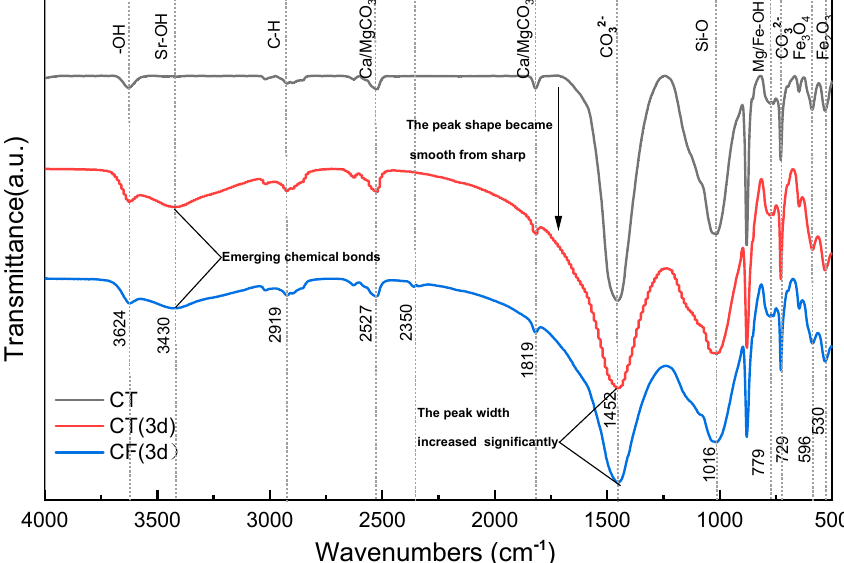
Figure 6. FTIR spectrum of claystone before and after the sorption of Sr. The FTIR spectra of claystone before and after Sr sorption show that the peak shape of the FTIR curve of claystone changed greatly after Sr sorption. In the absence of colloids, the peak intensity of the sorption peak at 3624 cm − 1 increased, but the displacement was not obvious. A new band appeared at 3430 cm − 1 , which had a weak peak intensity but a large peak width, indicating that the Sr in the solution formed a conjoining body with the free -OH in the claystone, and the degree of conjoining was high. In the process of Sr sorption by claystone, the chemical bond polarization was greatly increased and the vibration frequency was reduced due to intermolecular hydrogen bonding, so the peak intensity and peak width of the -OH sorption peak at 2700~2526.6 cm − 1 were increased and slightly shifted to a lower band. The intensity of the sorption peak at 1819 cm − 1 decreased, and the peak shape transformed from sharp to smooth. This is probably because when Mg/CaCO 3 was replaced with Sr in solution, the C=O length increased, the force constant decreased due to the conjugation effect, and the density of the corresponding electron cloud decreased. The [CO 3 ] 2 − bending deformation vibration peak width at 1452 cm − 1 increased more significantly after the sorption effect. This is mainly due to the bonding of Sr adsorbed on the claystone surface to form SrCO 3 , which reduced the vibrational frequency of this group. The peak width and peak intensity of the Mg/Fe-OH bond at 779 cm − 1 increased after sorption. This is caused by the substitution reaction of the adsorbed Sr with Mg and Fe plasma, and the generated Sr-OH has a stronger vibration frequency and high sorption intensity. In the low band region, the FTIR spectra changed significantly after sorption. This can be explained by the change in the active groups of the claystone in this band due to sorption and the destruction of Fe 3 O 4 and Fe 2 O 3 with sorption. Similar findings can be observed for the sorption of Sr by kaoslinite and magnesite [57] and minerals such as illite and goethite [58]. Sr could produce a complexation reaction with functional groups such as -OH and [CO 3 ] 2 − in claystone, adsorbing it to the claystone. At the same time, Sr can also have cation exchange reactions with Ca, Mg, etc. in the clay- stone. The reaction process can be expressed as follows: −OH + Sr (cid:2870)(cid:2878) ↔ Sr(OH) (cid:2878)